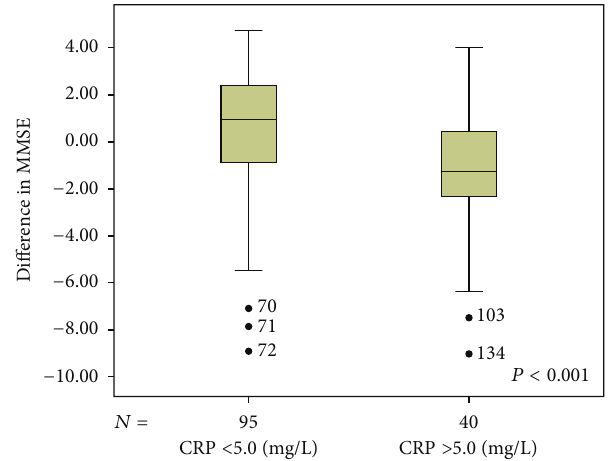
Figure 5: Δ MMSE distribution in those with high ( ≥ 5.0mg/L) and normal ( < 5.0 mg/L) CRP levels. Mean Δ MMSE (CRP ≥ 5.0 mg/L) = − 1.19, 𝑃 : 0.003, and that adjusted for covariates: − 1.13, 𝑃 : 0.031 (not shown). Mean Δ MMSE (CRP < 5.0 mg/L) = +0.52, 𝑃 : 0.003, and that adjusted for covariates: +0.30, 𝑃 : 0.031 (not shown). CRP: C-reactive protein; MMSE: Mini Mental Status